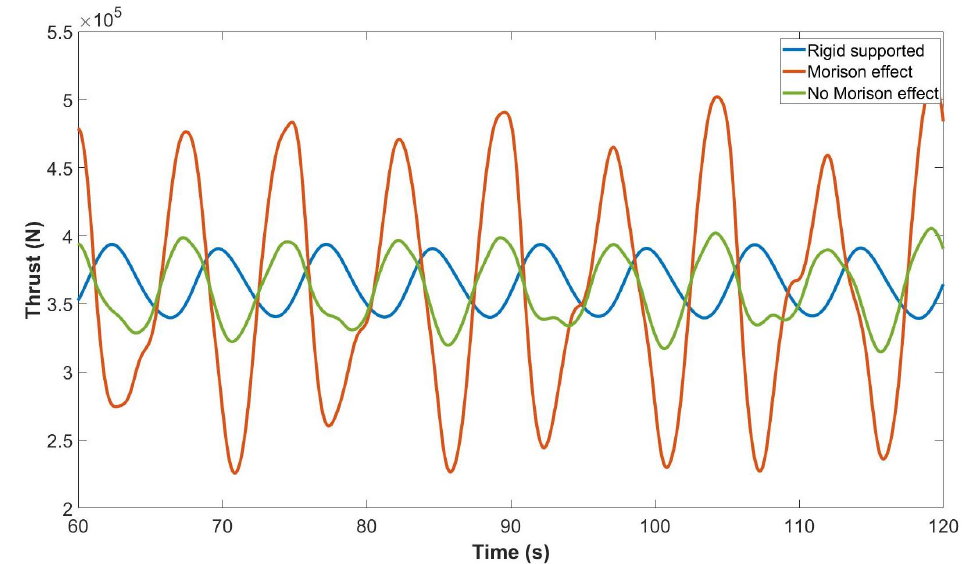
Figure 13. Morison effect in